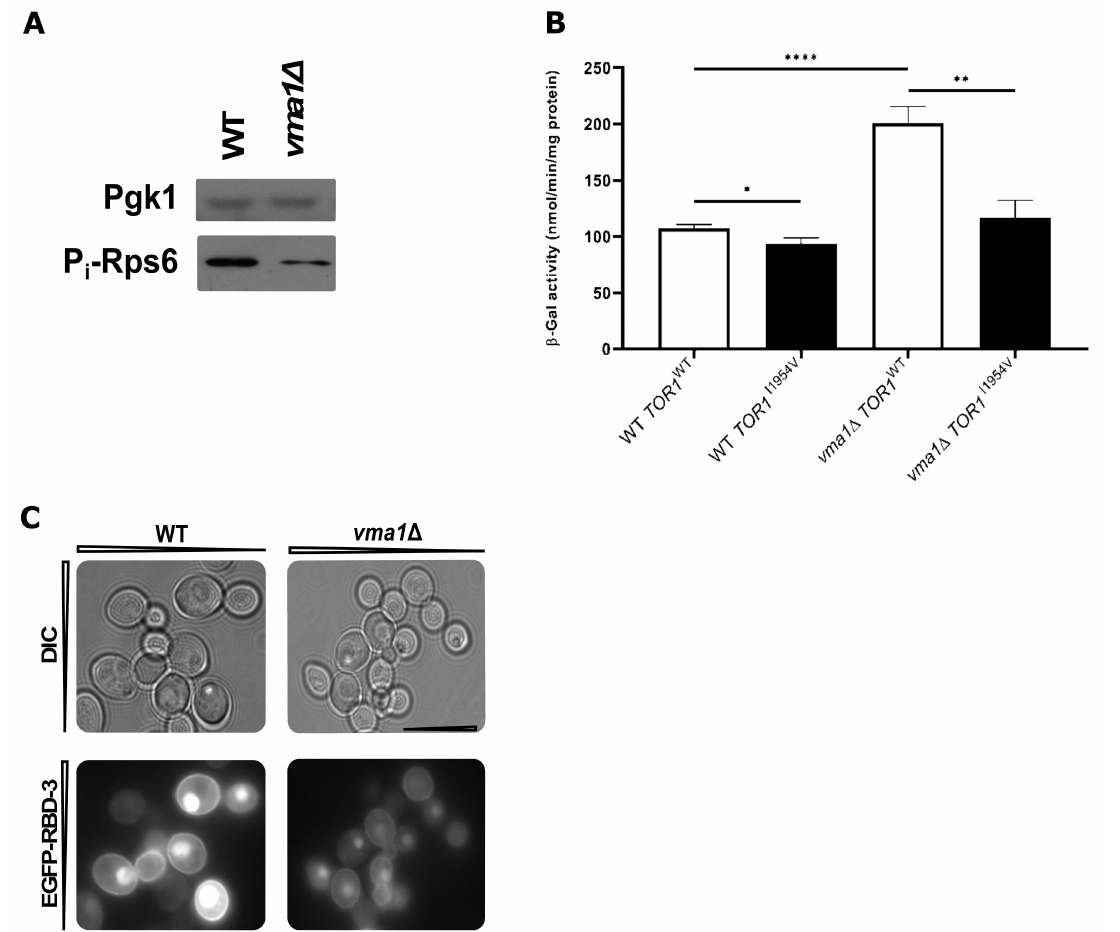
Figure 4. Loss of V-ATPase activity leads to lower TORC1 and Ras-PKA activation. ( A ) Western blot showing TORC1 activity changes in WT and vma1 ∆ cells, as measured by the phosphorylation of Rps6. Pgk1 was used as a loading control. WT cells were grown in SC medium to the exponential phase, and aliquots were collected and processed for Western blotting. ( B ) WT or vma1 ∆ cells expressing either WT or a hyperactive TOR1 allele ( TOR1 I1954V ) and YEp357- DGA1 -LacZ reporter gene were grown in SC medium lacking uracil and leucine to early stationary phase. Protein extracts were prepared, and specific β -Gal activities, with ONPG as a substrate, were determined by measuring the amount of o-nitrophenol released by the galactosidase-catalyzed hydrolysis process (as in Figure 2C). Results are mean ± SD of at least three independent experiments. * p ≤ 0.05; ** p ≤ 0.01; **** p ≤ 0.0001. ( C ) RBD-GFP localization was inspected in WT and vma1 ∆ cells grown in SC medium lacking uracil to the exponential phase. Scale bar, 2 µ